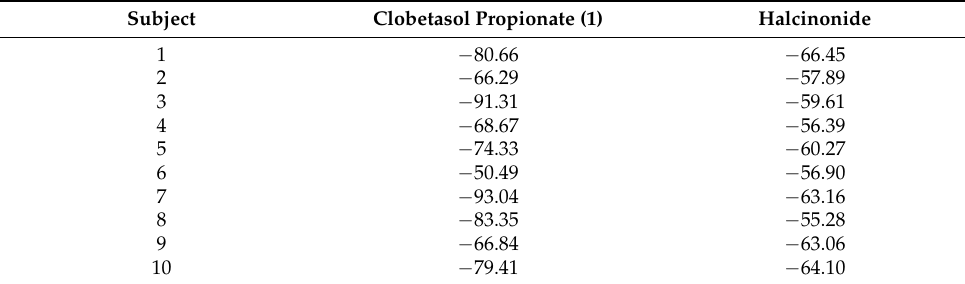
Table 2. Individual subject results ( E max values) from Study 1.